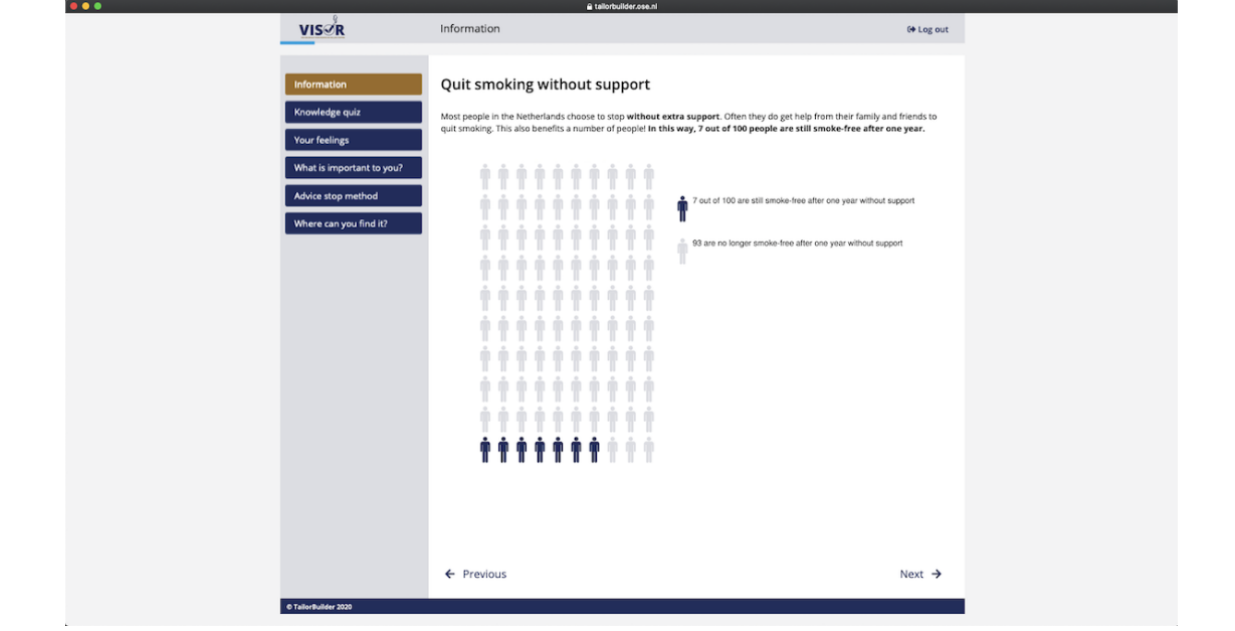
Figure 2. Screenshot of the information section in the decision aid (original text translated from Dutch).